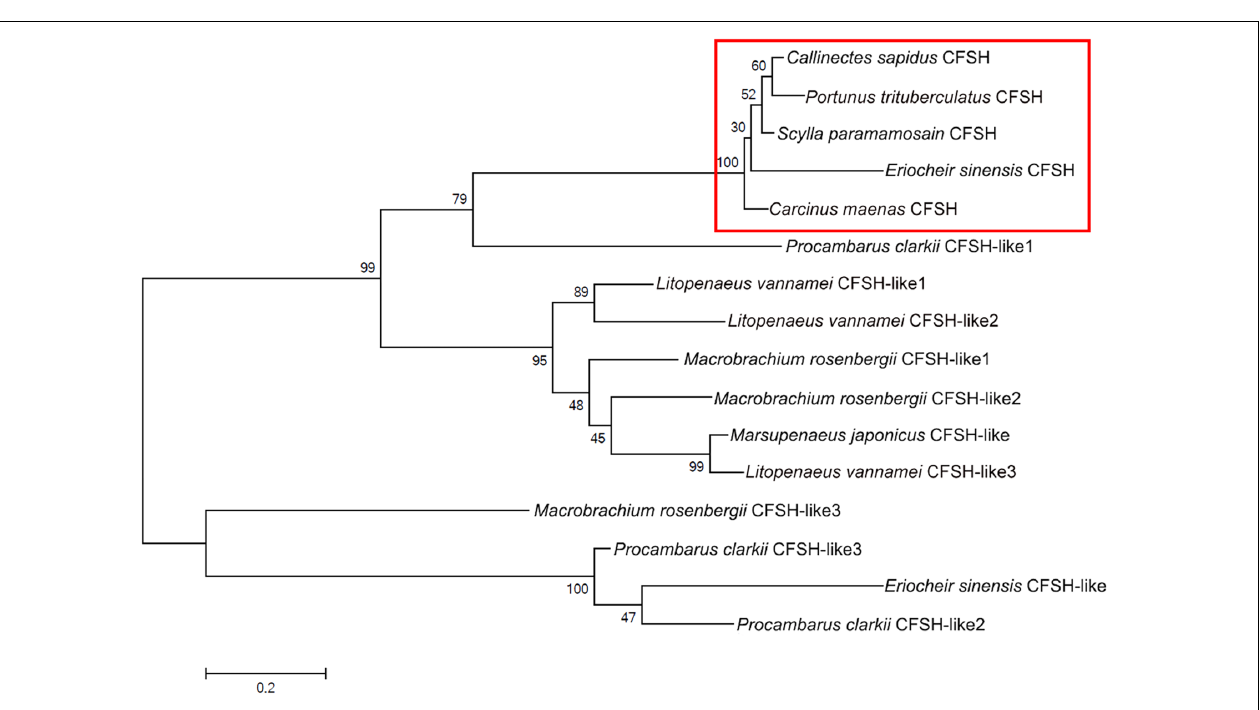
FIGURE 3 | Phylogenetic tree of amino acid sequences of the CFSH in decapod crustaceans. The tree was built by the maximum likelihood (ML) method. Callinectes sapidus (GenBank accession number: GU016328.1), Carcinus maenas (GenBank accession number: HM594946.1), and the other sequences of CFSH were obtained from (Veenstra,